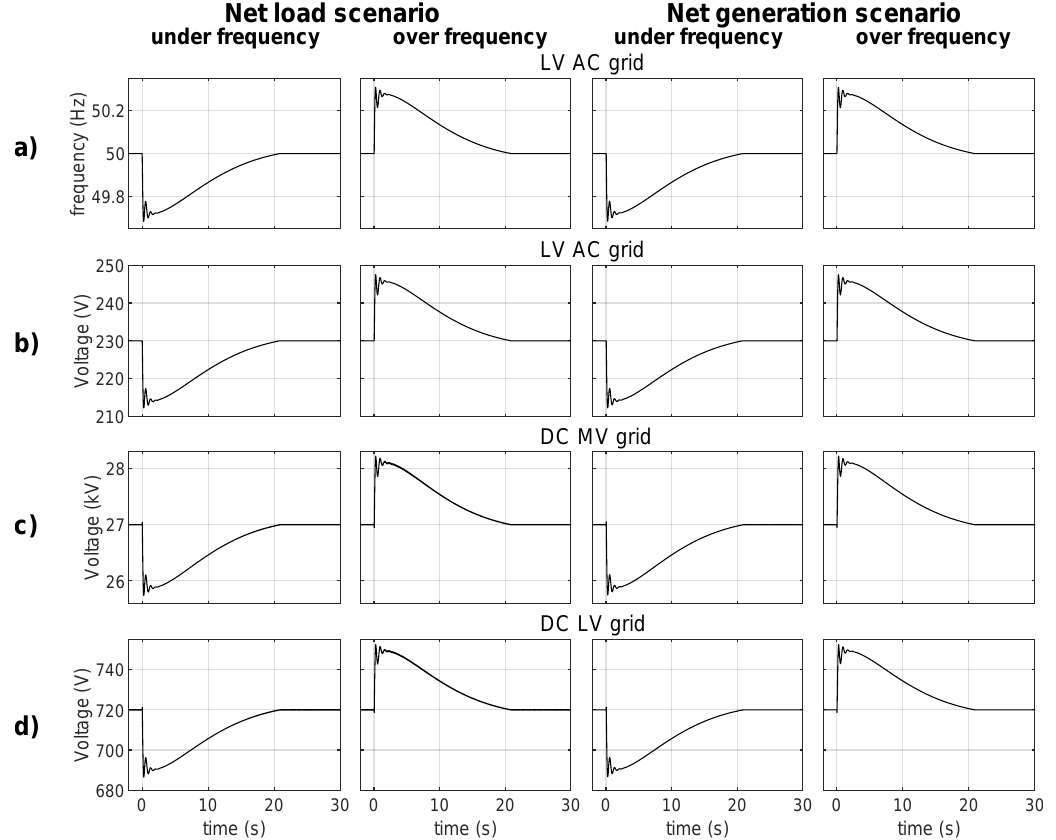
Figure 19. ST (droop controller) response to the frequency variations observed in the MV AC network for the net load and net generation scenarios, in terms of voltage and frequency in the hybrid AC/DC network: ( a )— f LV ( f MV ) droop; ( b )— V LV ( f MV ) droop; ( c ) and ( d )— VDC ( f MV )